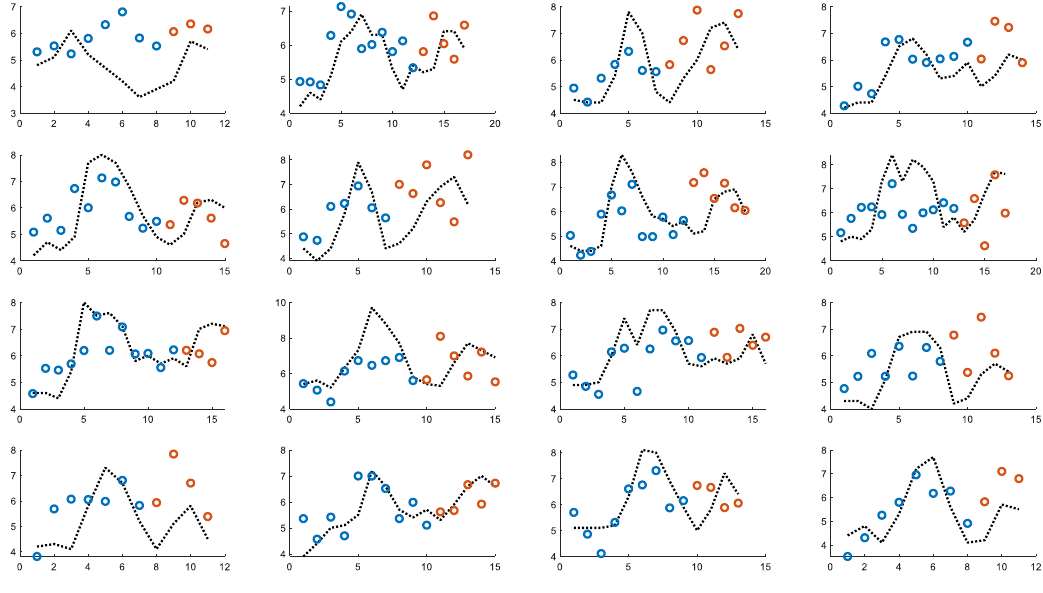
Fig.10: PLS model with five components based on NIR, resistance and reactance. Globally trained until the start of intake of sugar-containing soft drink for the second time (blue dots) and thereafter used for prediction orange